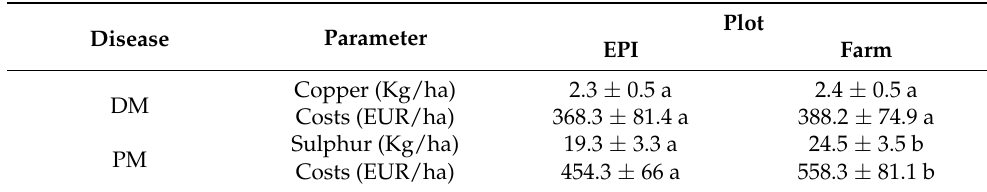
Table 5. Averages and standard deviations of the amounts of copper and sulphur applied in EPI and farmers’ plots and treatments costs for 2021. Different letters indicate significant differences between plots ( p <